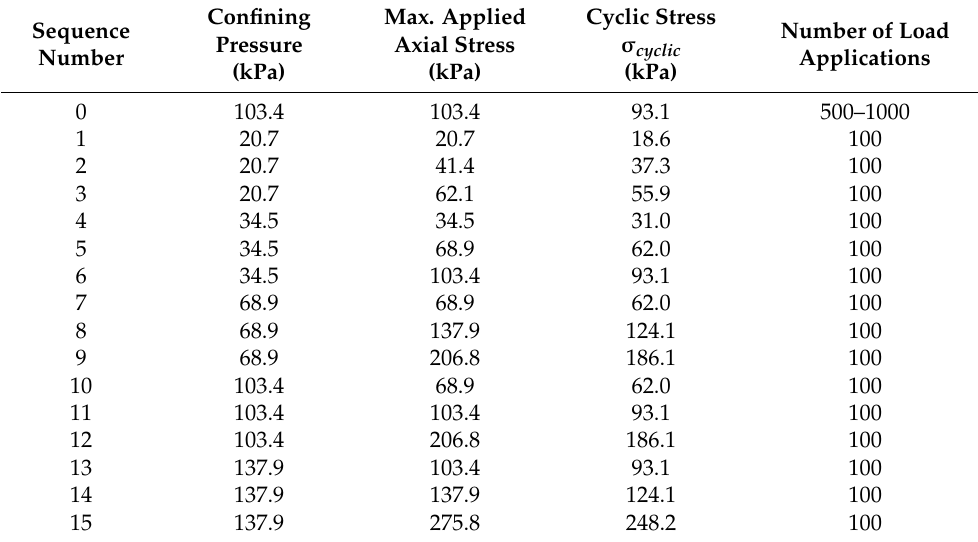
Table 2. Testing sequences for base or subbase material after [6].